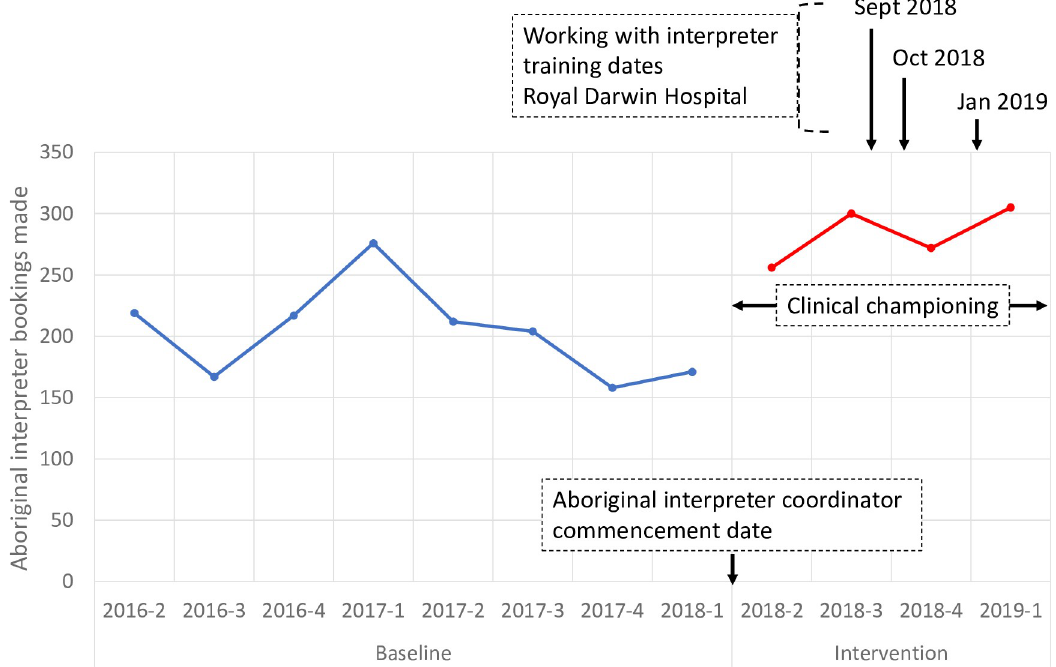
Fig 1. Plot of raw data showing Aboriginal interpreter booking numbers made at royal Darwin hospital per quarter during the study baseline and intervention periods, annotated to show timing of intervention components. Blue line: baseline period; red line: intervention